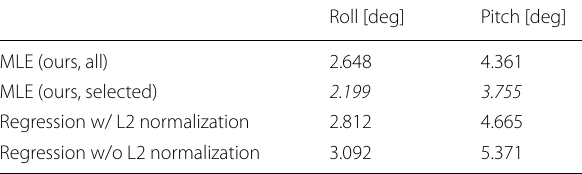
Table 9 MAE of estimated attitude in real world (#4)